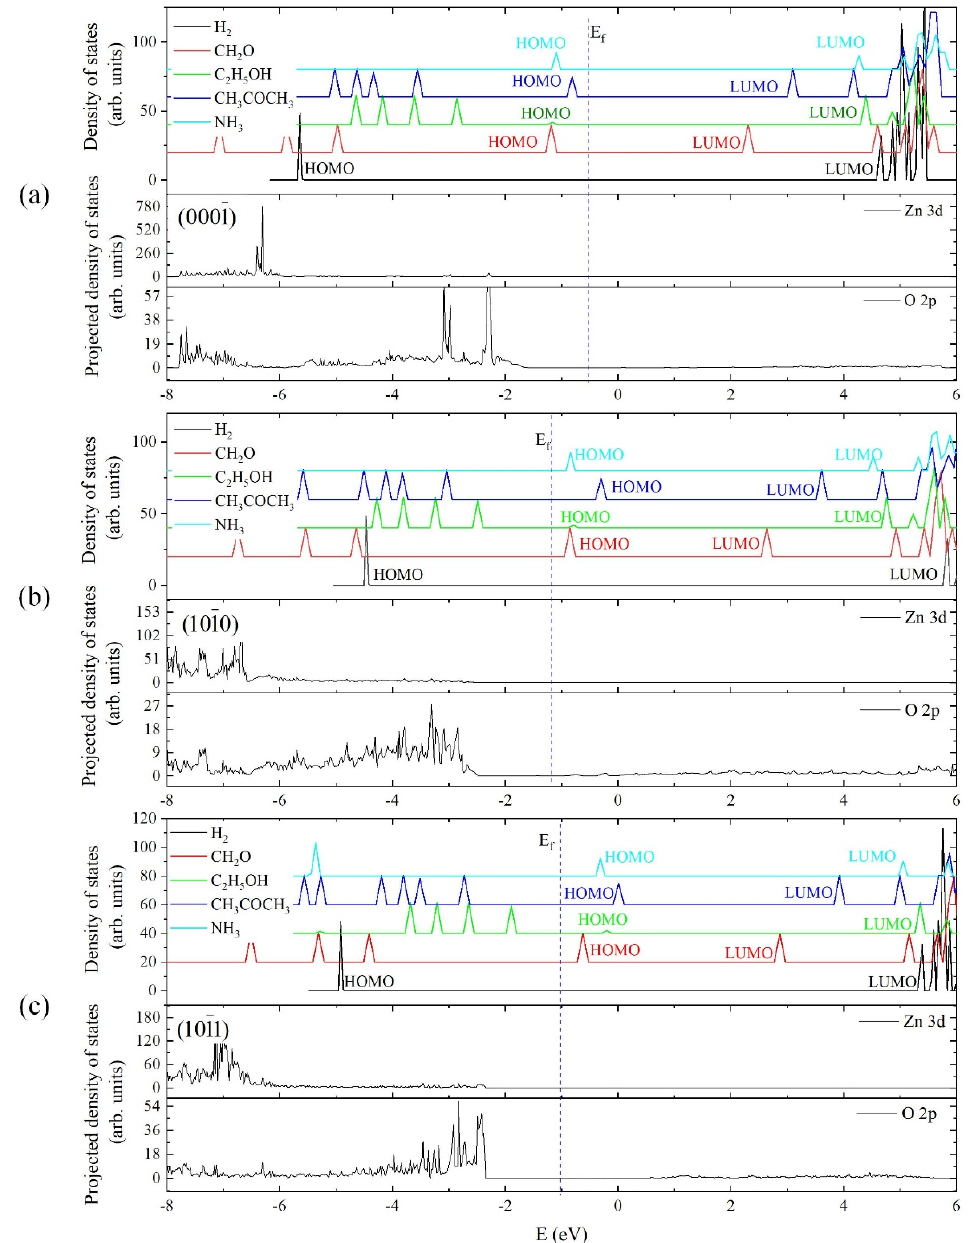
Figure 7. Density of states and projected density of states analysis for the adsorption systems of ( a ) ZnO(0001) , ( b ) ZnO(1010) and ( c ) ZnO(1011) before gas–slab interactions.